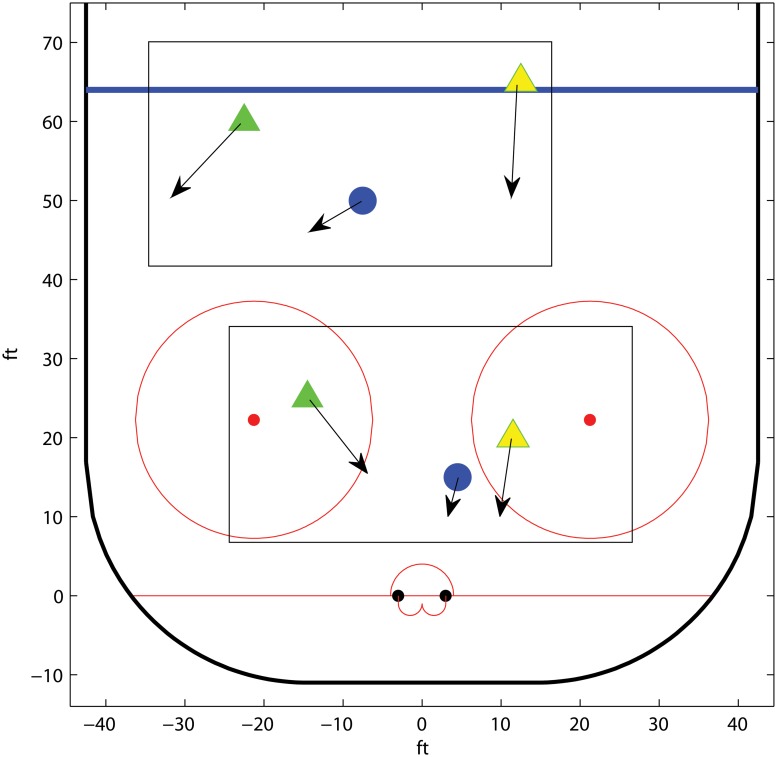
Outline of the optimal trajectories in the example Ice hockey; two against one.The offensive players are denoted by triangles, where a solid triangle marks the possession holder, and the defender is denoted by a circle. In the upper rectangle, B
1 puts pressure on the puck holder A
1, who avoids confrontation to await A
2. In the lower rectangle, having steared A
1 into a worse position, B
1 shifts focus to A
2, in order to decrease the greater threat posed by that player.